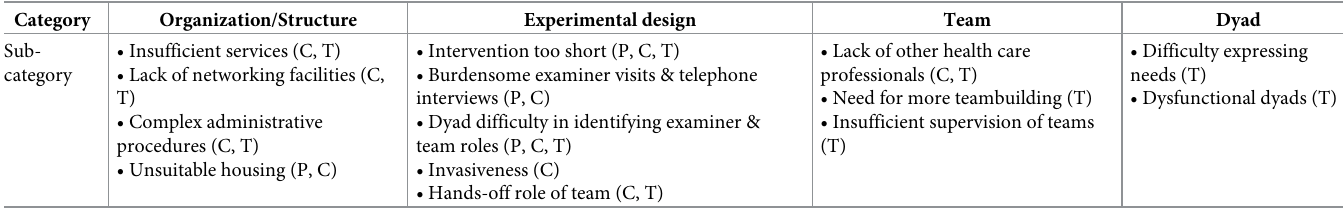
Table 5. The four barrier categories (columns) and 14 sub-categories (rows) reported by participants.